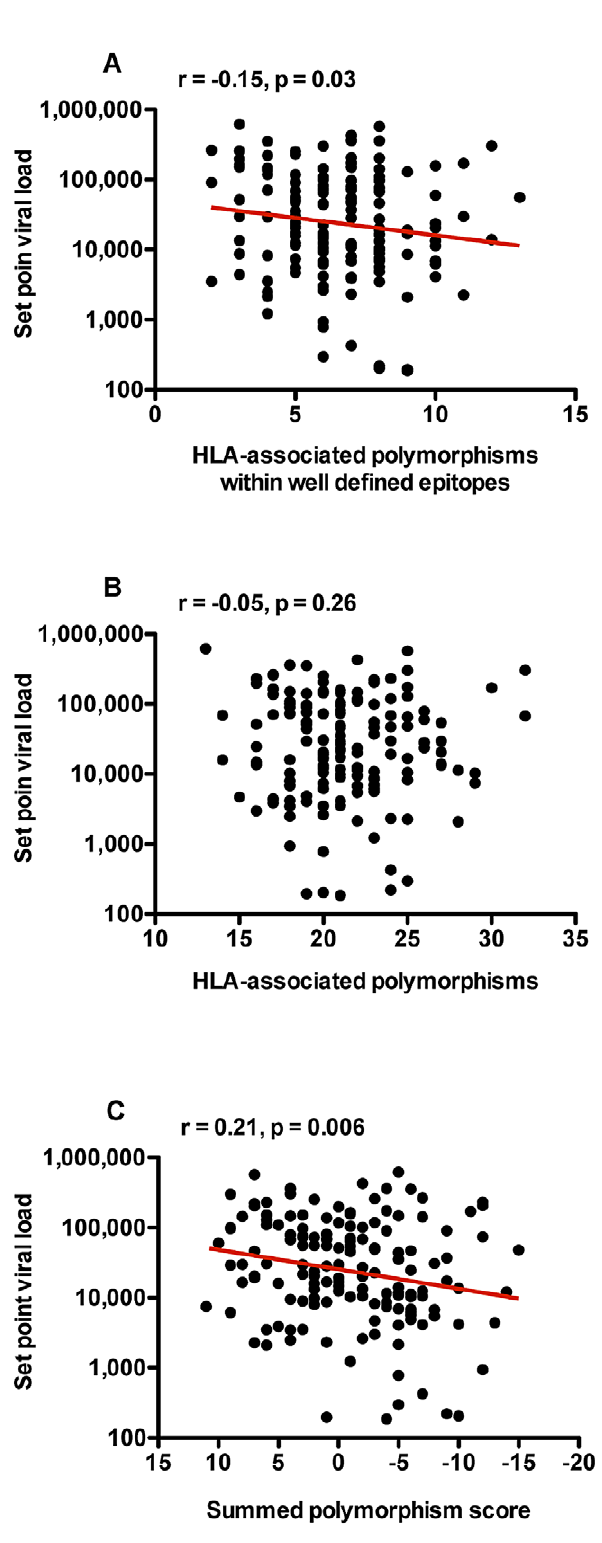
Figure 6. The balance of HLA-associated fitness increasing and decreasing mutations strongly correlates with set point viral load in newly infected individuals. (A) The number of HLA- associated amino acid polymorphisms within well-defined epitopes for each Gag protein negatively correlates with set point VL. (B) The total number of HLA-associated polymorphisms (including those outside well-defined CTL epitopes) in Gag does not correlate to set point VL